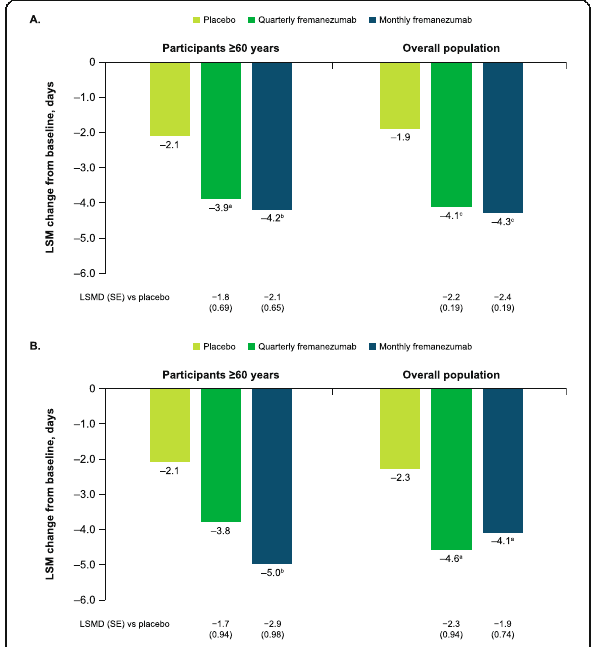
Fig. 2 Change in weekly migraine days in A ) participants aged ≥ 60 years and B ) overall population. LSM, least-squares mean; LSMD, least-squares mean differences; SE, standard error. Data shown are the LSM changes from baseline in the weekly average number of migraine days over the first 4 weeks of double-blind treatment. a P < 0.01 vs placebo. b P < 0.05 vs placebo. c P < 0.0001 vs placebo Disability and quality-of-life outcomes